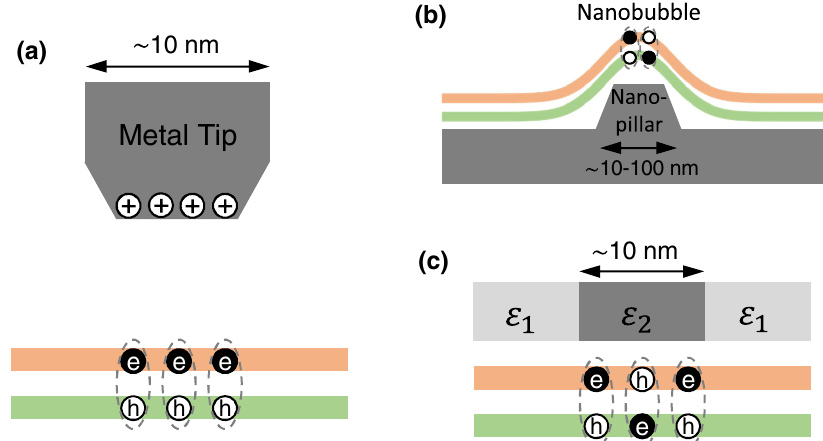
FIG. 8. (a) A positively (negatively) charged nanoscale metal tip can trap the dipolar excitons at B sites with electric dipole down ( C sites with electric dipole up). Alternatively, the role of the movable tip can be played by a local gate. (b) The local tensile strain in a nanobubble can trap both B - and C -site excitons, which can be engineered by placing the bilayer on a nanopillar. (c) By engineering the local dielectric environment, the excitons can be trapped to the area with a larger dielectric